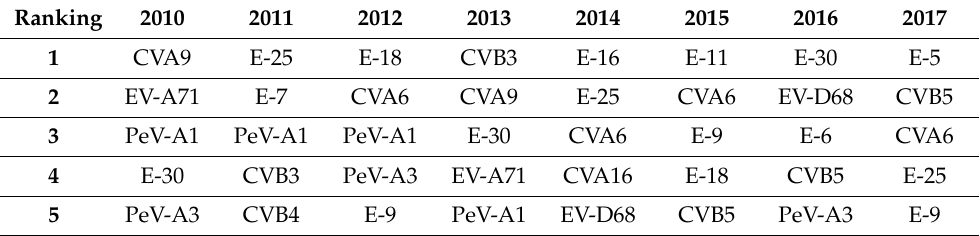
Table 1. VIRO-Typened top five most prevalent viruses circulating between 2010 and 2017 in the Netherlands (adapted from Benschop 2016, source VIRO-TypeNed). EV; enterovirus, PeV; parechovirus, CVA; coxsackievirus A, CVB; coxsackievirus B, E;